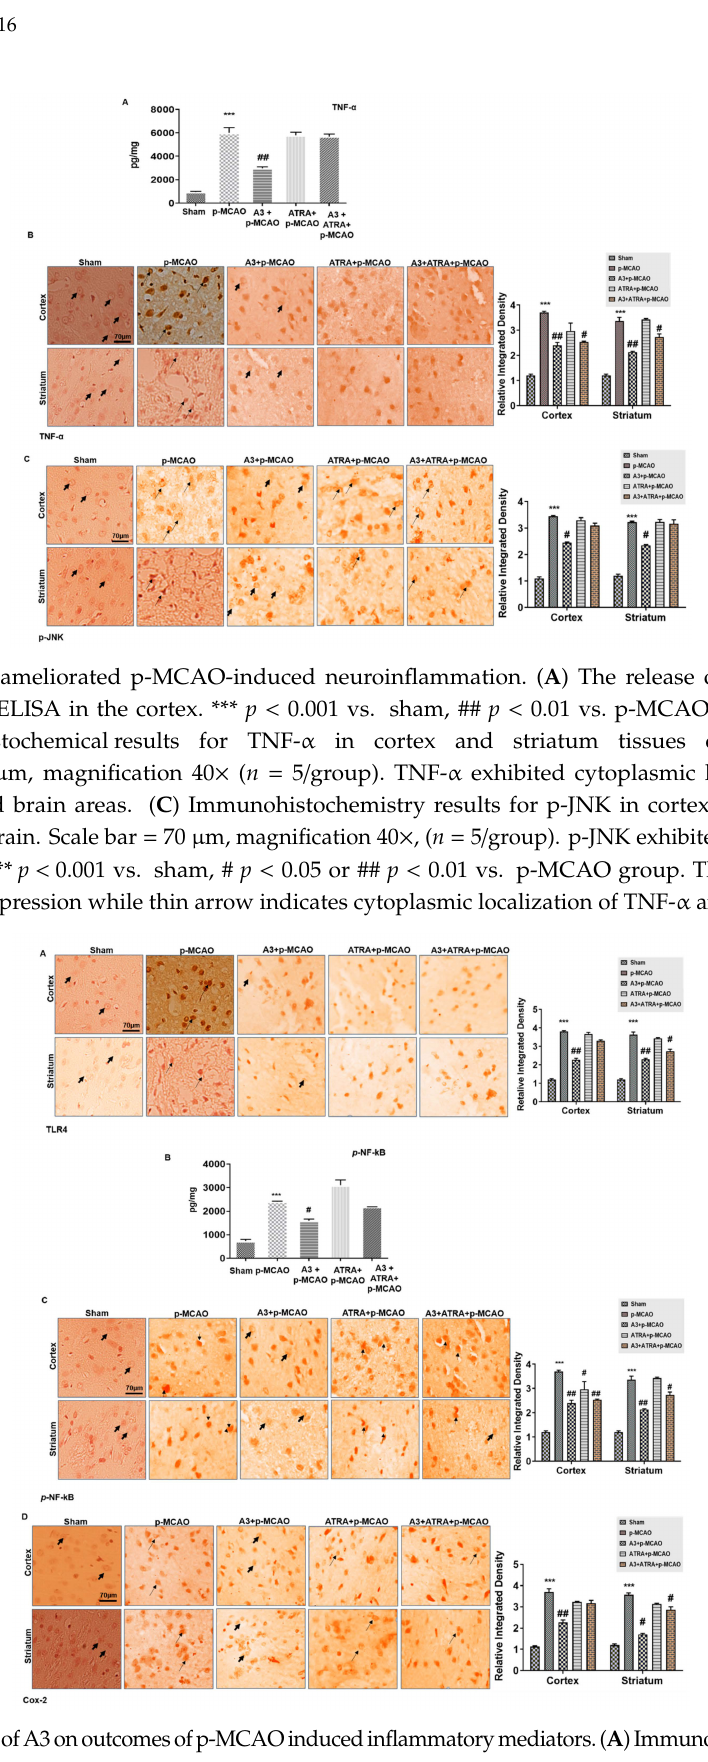
Figure 7. EffectofA3onoutcomesofp-MCAOinducedinflammatorymediators.( A )Immunohistochemistry images of TLR4 in cortical and striatal tissues of the brain. Scale bar = 70 µ m, magnification 40 × , ( n = 5 / group). ( B ) Quantification of p -NF- κ B expression by ELISA in the cortex. *** p < 0.001 vs.